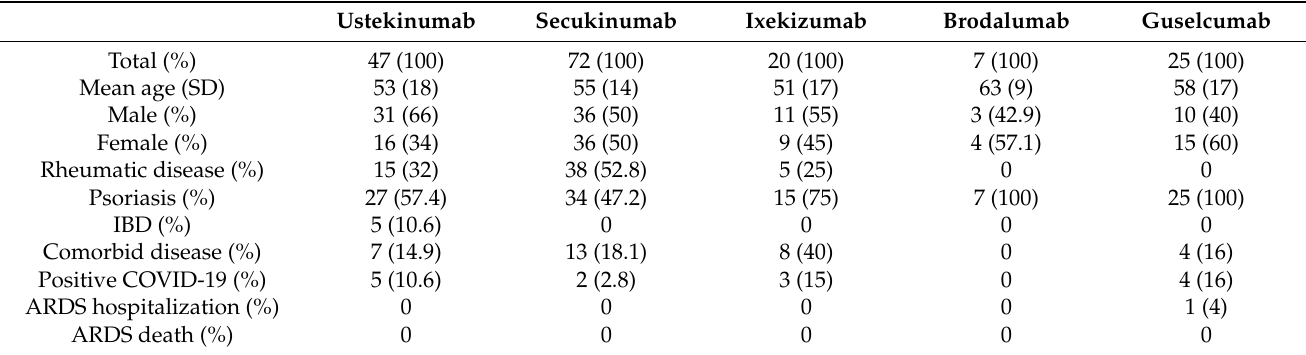
Table 2. Characteristics of patients treated with interleukin